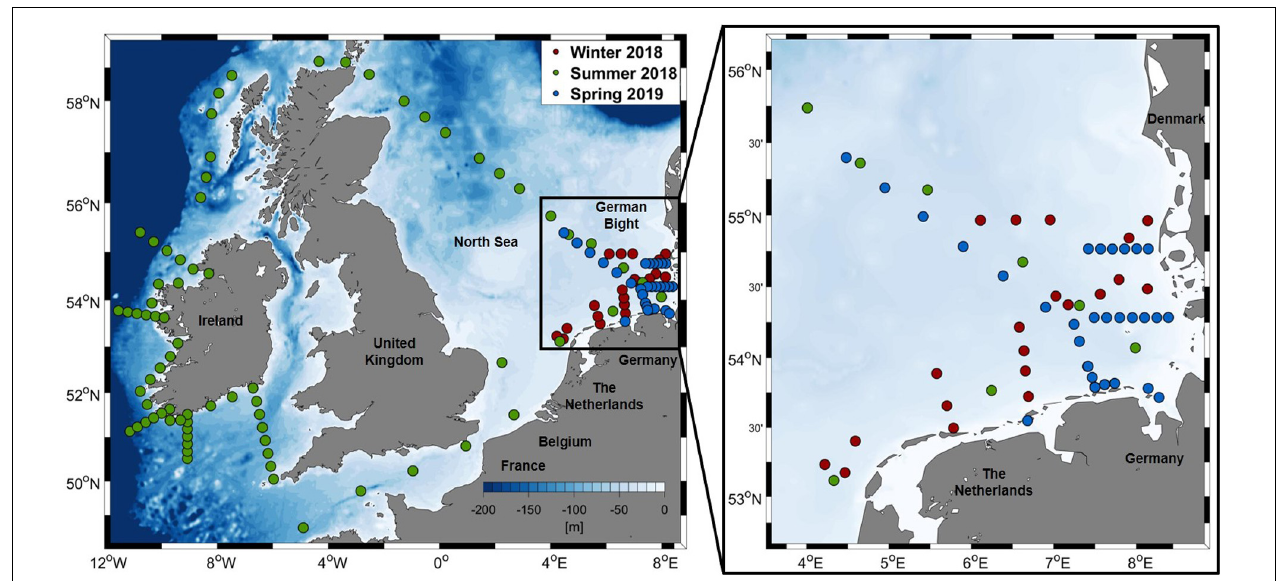
FIGURE 1 | Area of research with sampling stations, categorized by cruise (left) , close-up of the German Bight area (right